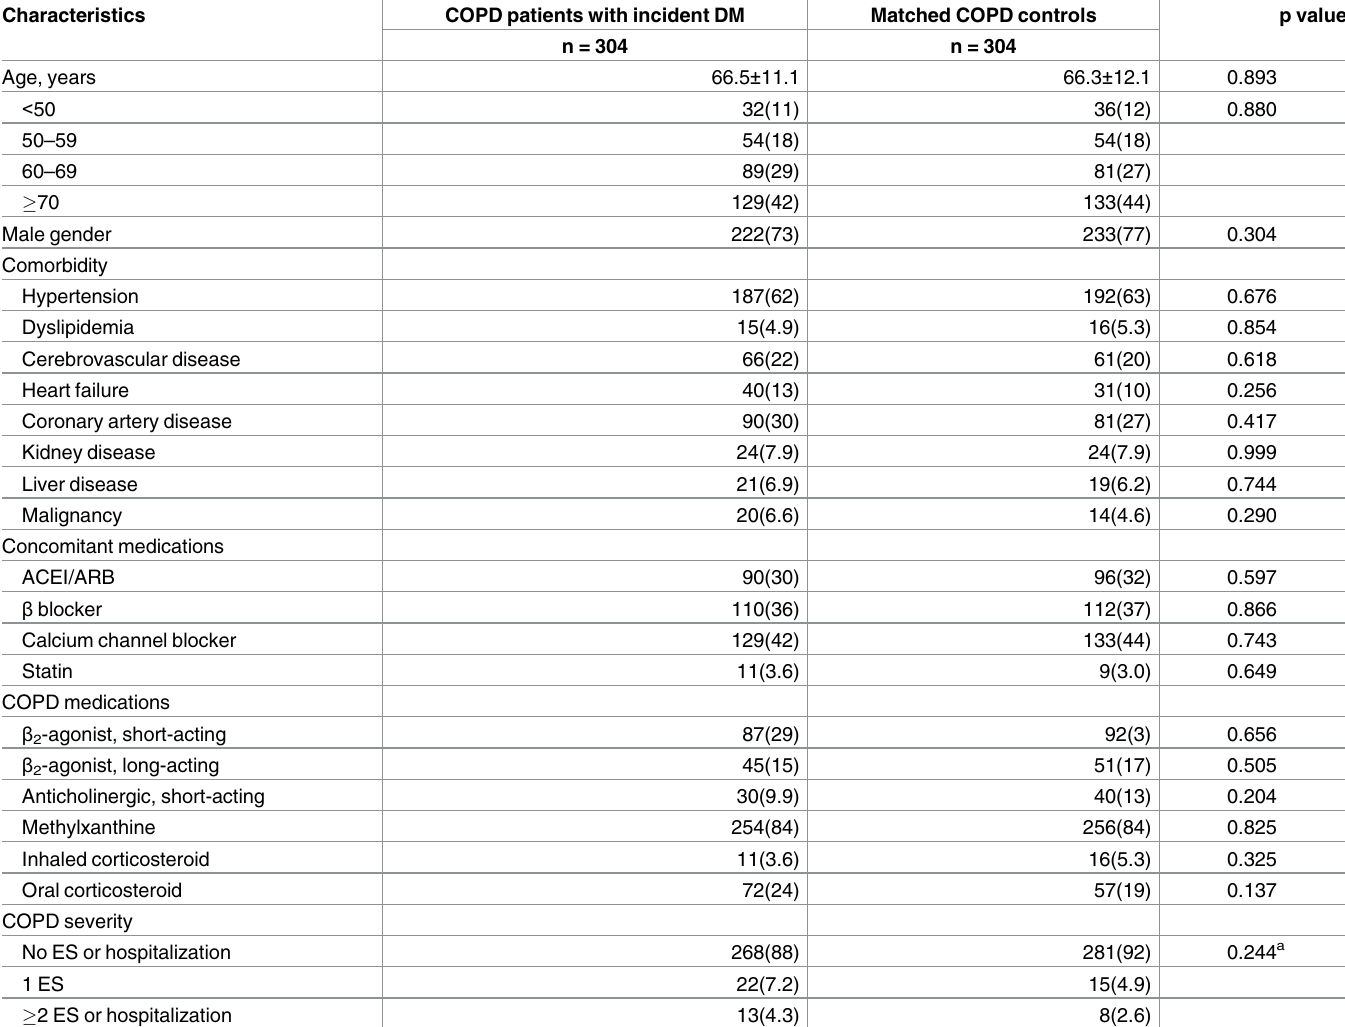
Table 5. Comparison of featuresbetween COPD patients with incident DM and matched